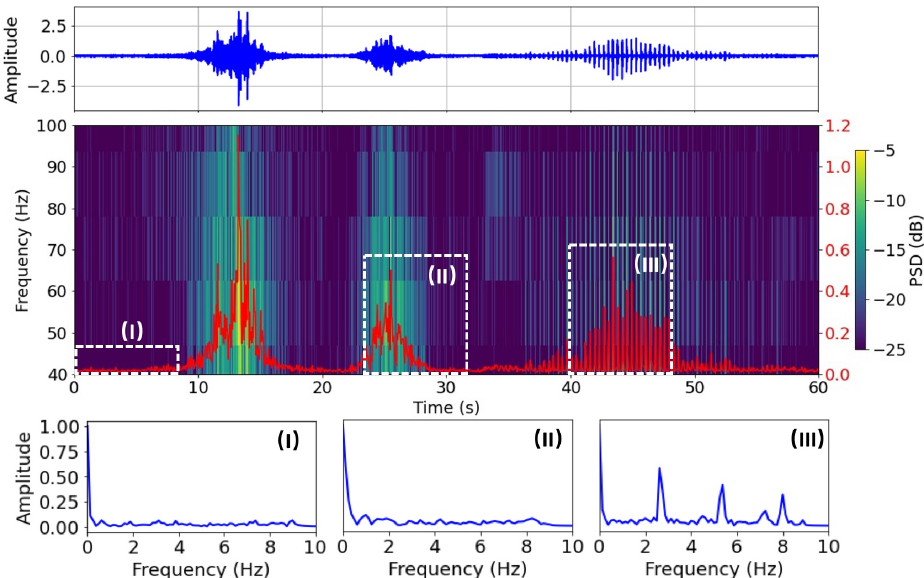
Figure 5. Illustration of the method for runner identification. Top panel : N-component seismic data filtered between 40 Hz and 100 Hz. Middle panel : spectrogram of the seismic data. The overlying red line is the total PSD summed between 40 Hz and 100 Hz. Bottom panel : normalized amplitude spectra of three 8-second segments of the PSD corresponding to background noise ( I ), motor vehicle signal ( II ), and runner signal ( III ). The runner signal is identified by strong